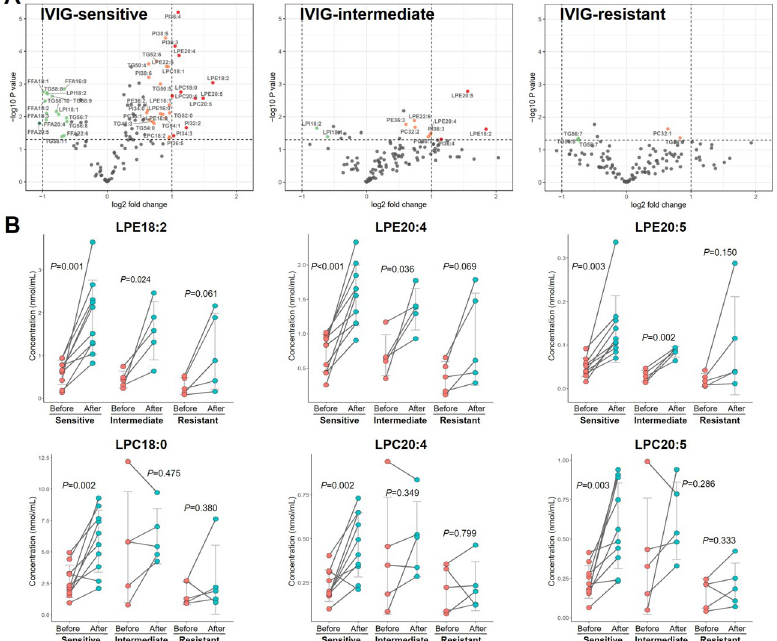
Fig 4. (A) Volcano plots for the lipid changes after treatment in IVIG-sensitive, IVIG-intermediate, and IVIG- resistant groups. The lipid species with a change fold of more than 50% and a P value less than 0.05 were considered significant changing features and annotated in color. (B) The concentration of significantly changed LPE and LPC species among the three IVIG-response groups. Scatters in red and cyan stand for the samples before and the samples after treatment, respectively. Solid lines connecting two points indicate the same